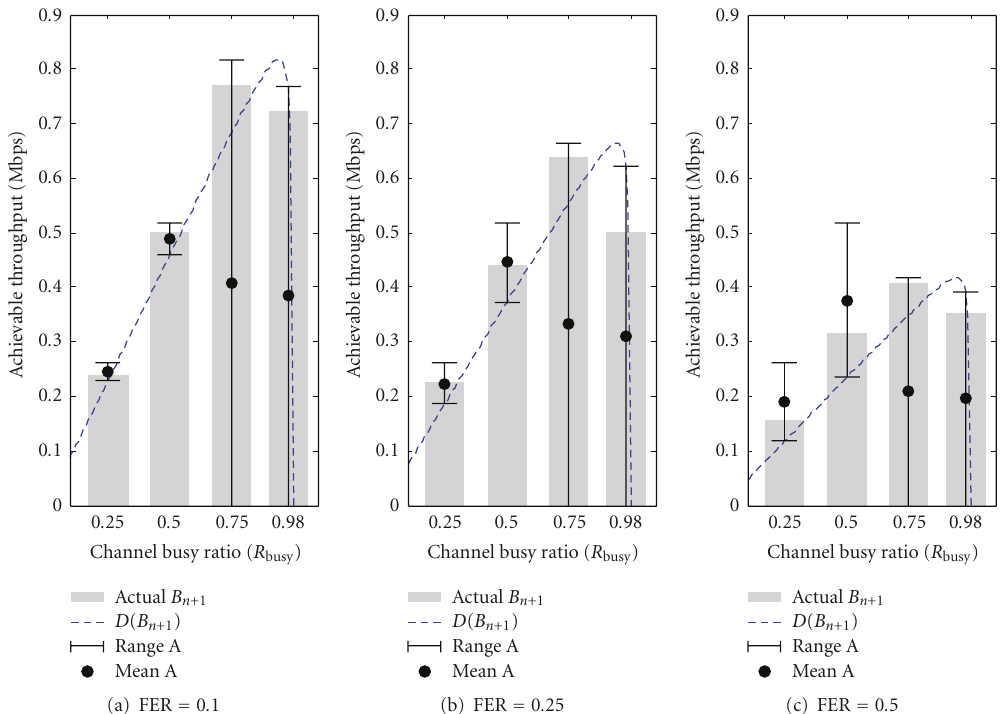
Figure 11: Case 3: achievable throughput estimation for n = 3 & CR = 5 . 5